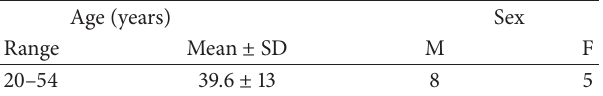
Table 2: Healthy donors’ characteristics. First row indicates all the variables analyzed in healthy controls, second row indicates the subgroups for each variable, and third row indicates the number of subjects in each